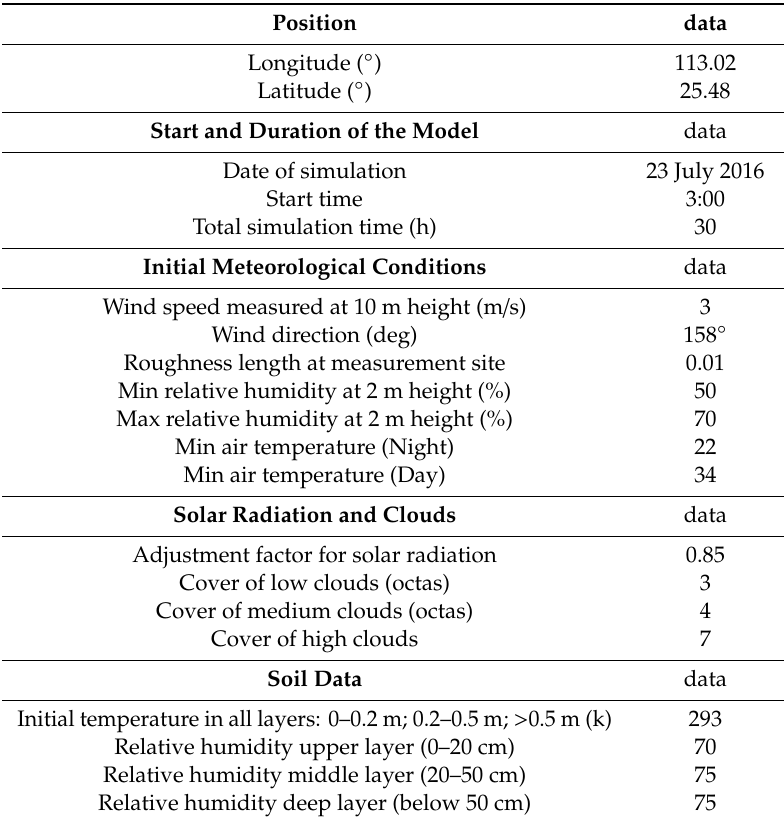
Table 2. Configuration data applied in the Envi-met simulation